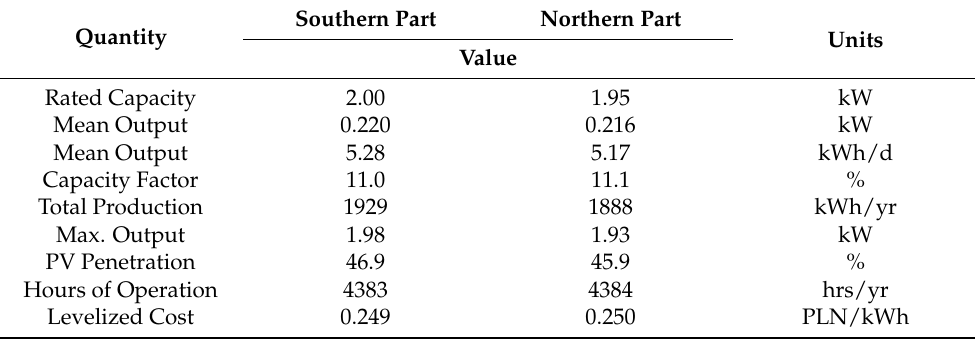
Comparison of the possibilities of a photovoltaic panel in two zones of the Lubuskie Voivodeship.